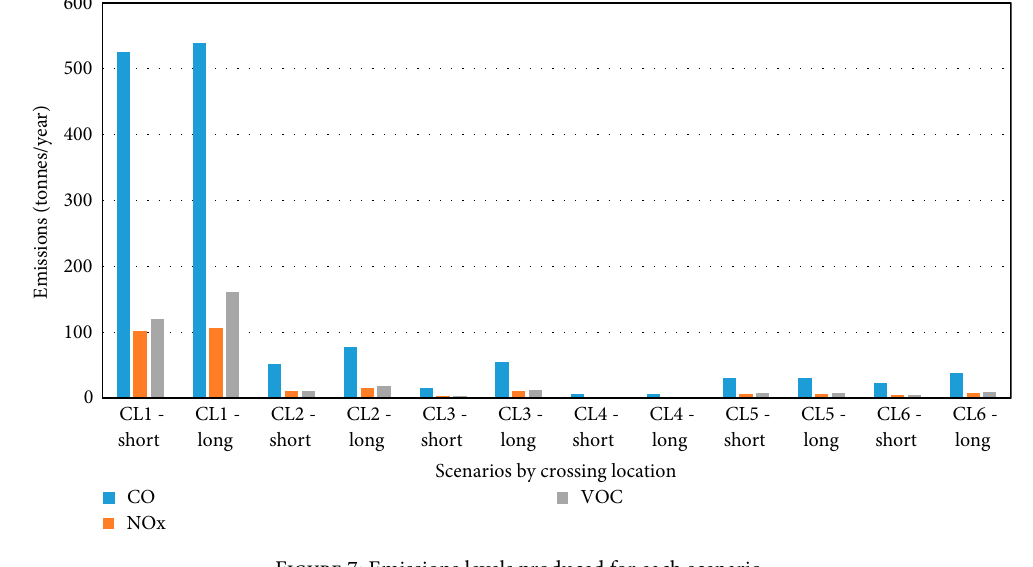
Figure 7: Emissions levels produced for each scenario.